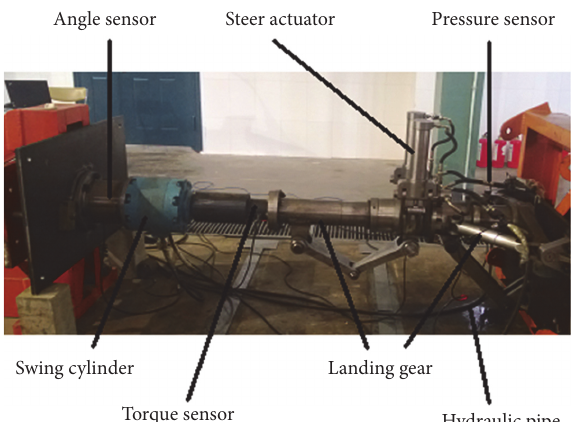
Figure 22: Test equipment installation.